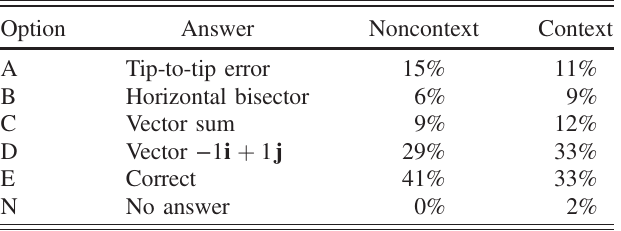
TABLE XI. Results of item 9: Students have to choose the representation of the vector difference or change of